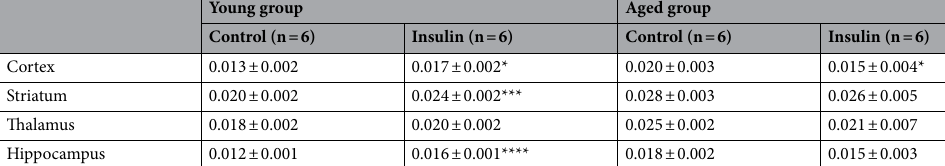
Table 5. 18 F-FDG accumulation in brain regions in mice (%ID/p/kg). Data are shown in parentheses (mean ± SD). Control, control group; Insulin, insulin-loaded group. * P < 0.05, *** P < 0.001, **** P < 0.0001 vs control